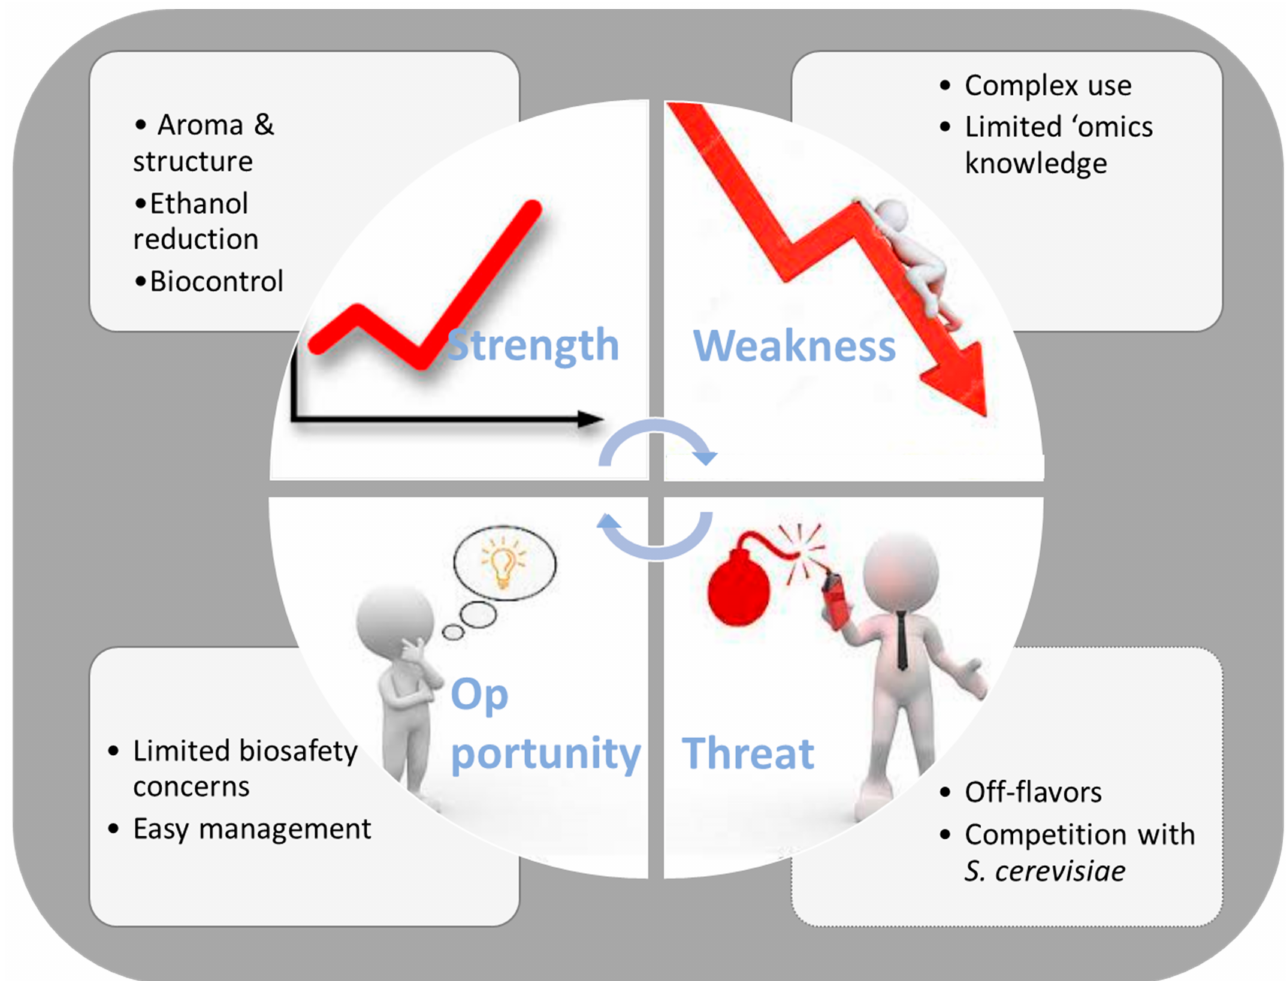
Figure 3. SWOT diagram, summarizing the strengths (S), weaknesses (W), opportunities (O), and threats (T) of the current management of non-Saccharomyces